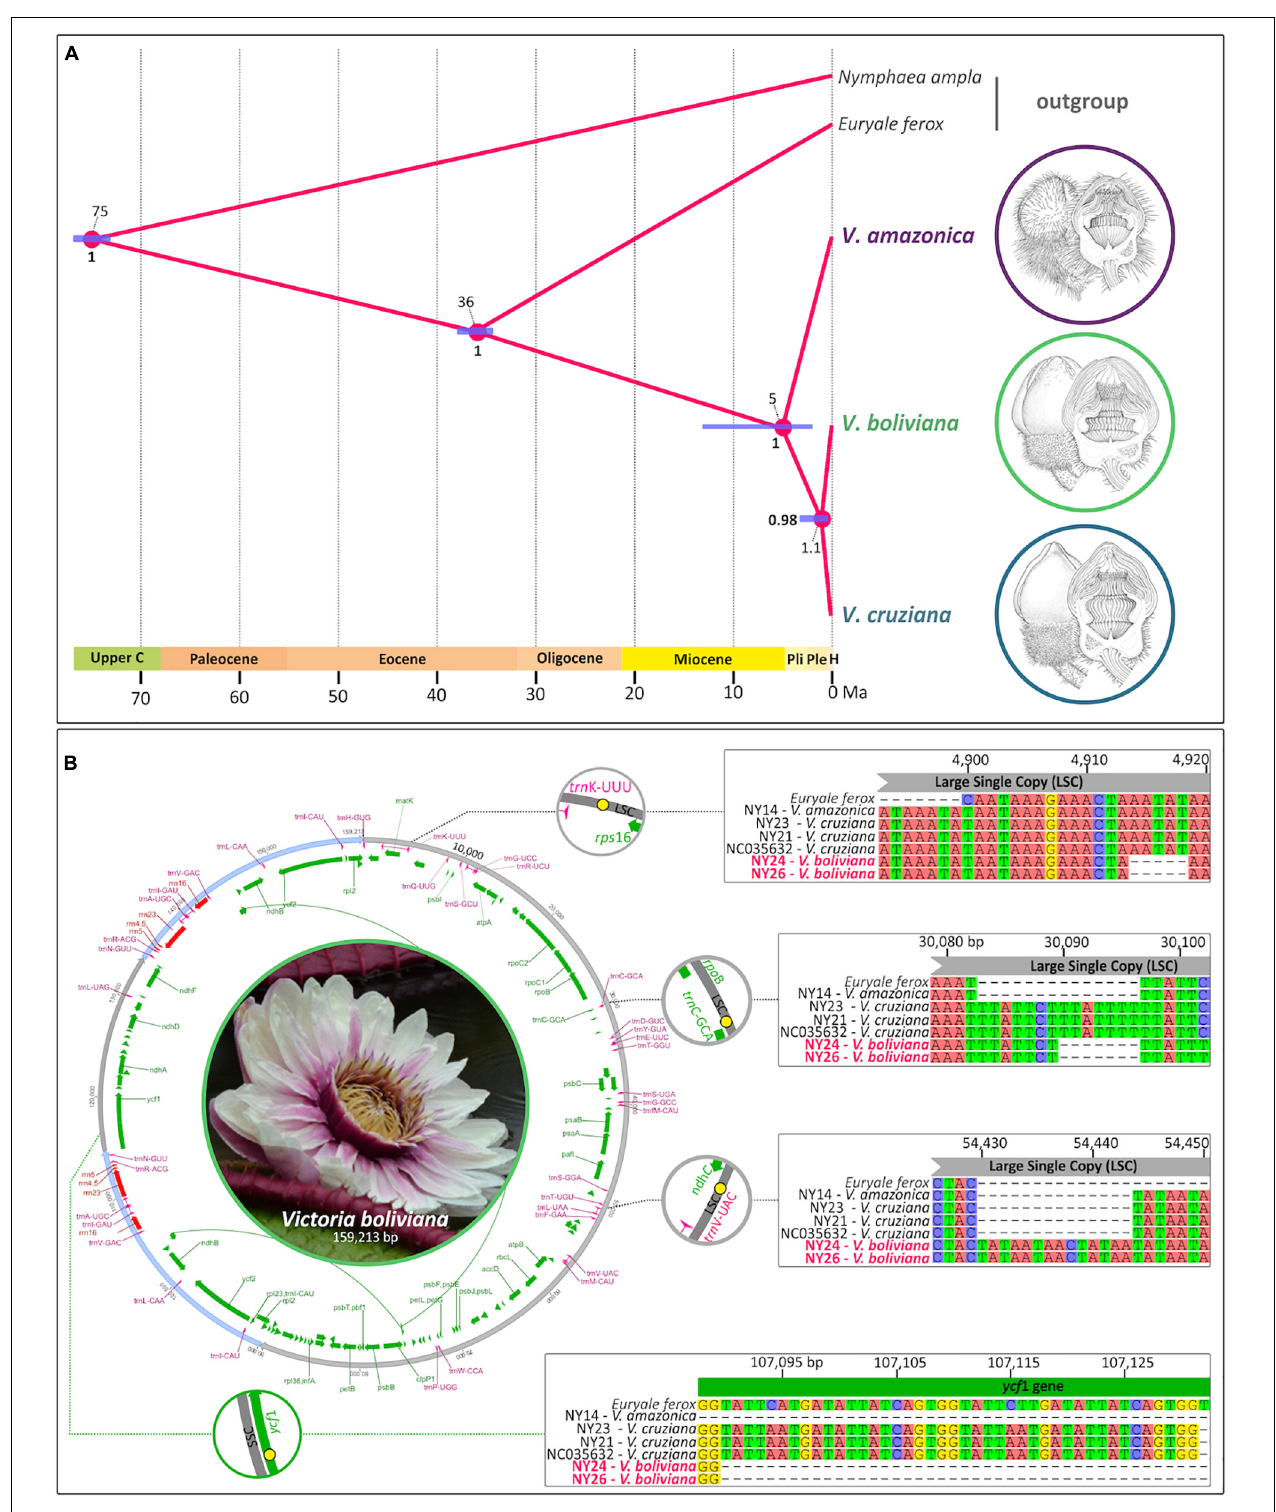
FIGURE 7 | (A) Chronogram tree from StarBEAST2 representing molecular dating analysis of splits between V. amazonica, V. cruziana, and V. boliviana with confidence intervals highlighted. (B) Visual representation of plastid structure of V. boliviana assembled using GetOrganelle, with genomic locations of diagnostic characters indicated. Details of polymorphisms (indels) – in the context of multi plastid alignments – displayed within insets.